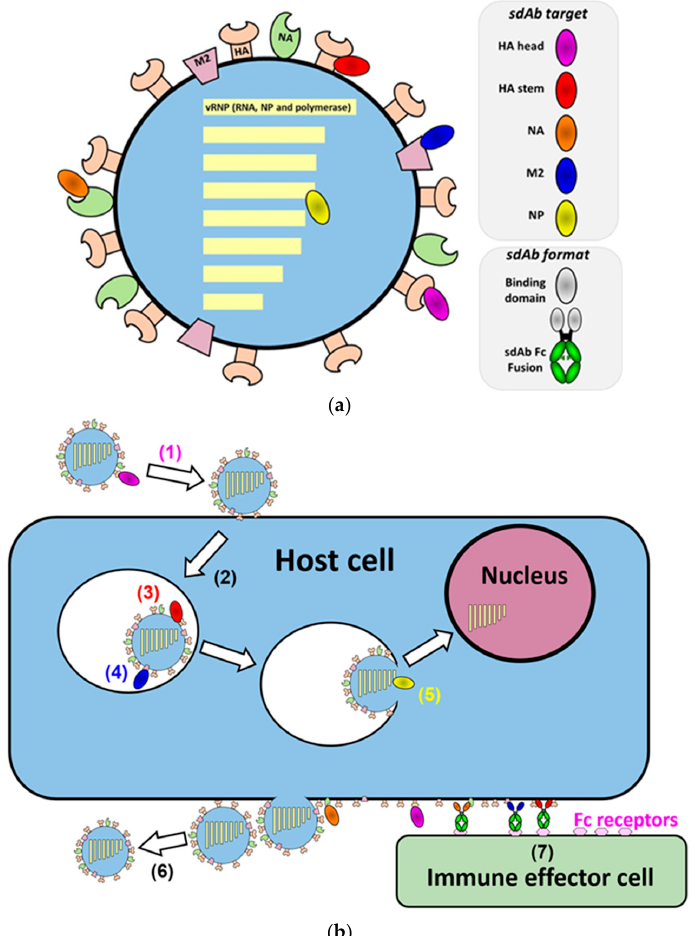
Figure 1. Relationship between sites of antibody binding and mechanisms of inhibition of infection of influenza virus. ( a ) Cartoon of influenza virus, its envelope proteins, the sites targeted by anti-influenza sdAbs and different sdAb formats. HA head (sdAb binding to hemagglutinin head domain), HA stem (sdAb binding to hemagglutinin stem domain), NA (sdAb binding to neuram-inidase), M2 (sdAb binding to M2 ion channel), NP (sdAb binding to nucleoprotein, a component of the vRNP complexes) ( b ) Cartoon depiction of parts of the influenza virus infection cycle and the various methods by which antibodies inhibit the spread of the virus depending on their epitope. The infected host cell, influenza virus, nucleus and effector cell are indicated (1) Virus attachment to host cell inhibited by HA head antibodies. (2) Endocytosis of virion. (3) pH mediated fusion of virus and host membranes inhibited by HA stem antibodies. (4) pH mediated proton influx inhibited by some M2 antibodies interfering with uncoating. (5) Transport of ribonucleoproteins to the nucleus inhibited by NP antibodies. (6) Inhibition of dissociation of new virions from host cells by anti-NA antibodies. (7) Immune effector functions such as antibody dependent cellular cytotoxicity (ADCC) mediated by Fc-linked HA stem, NA and M2